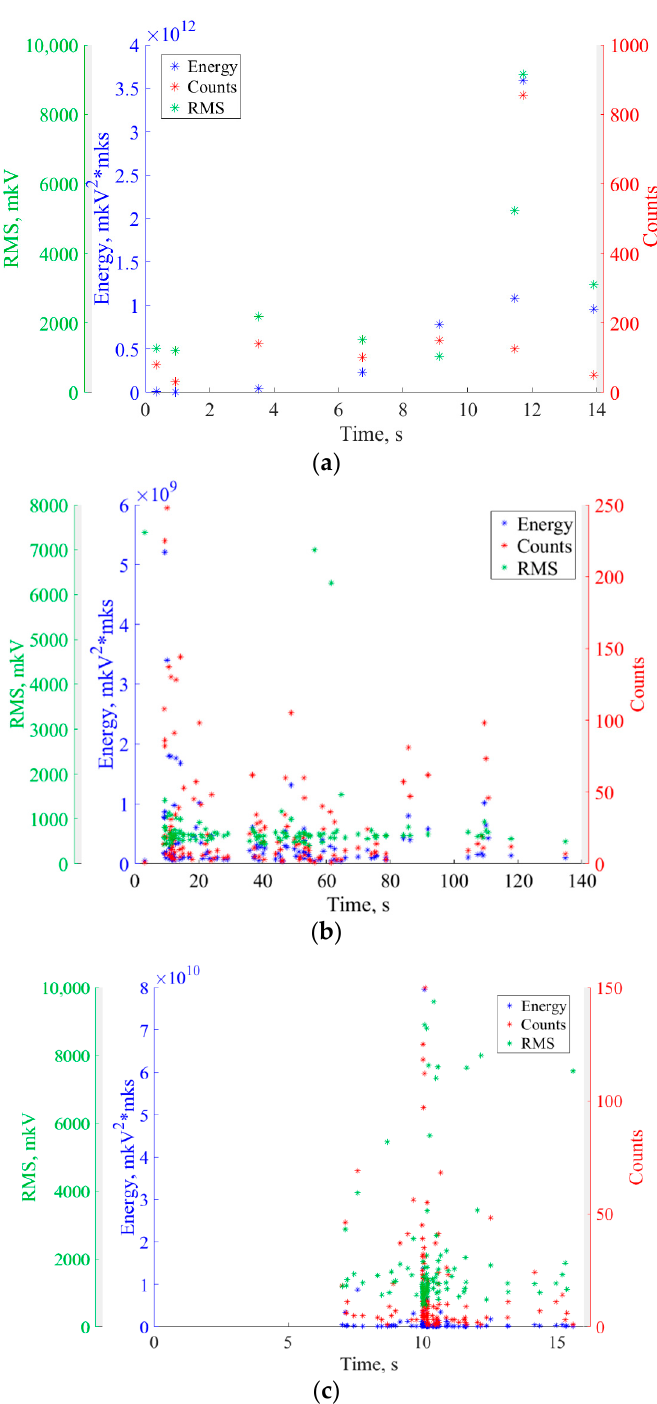
Figure 6. Temporal dependencies of AE parameters in rail ( a ), wheelset ( b ), and traction clamp ( c )